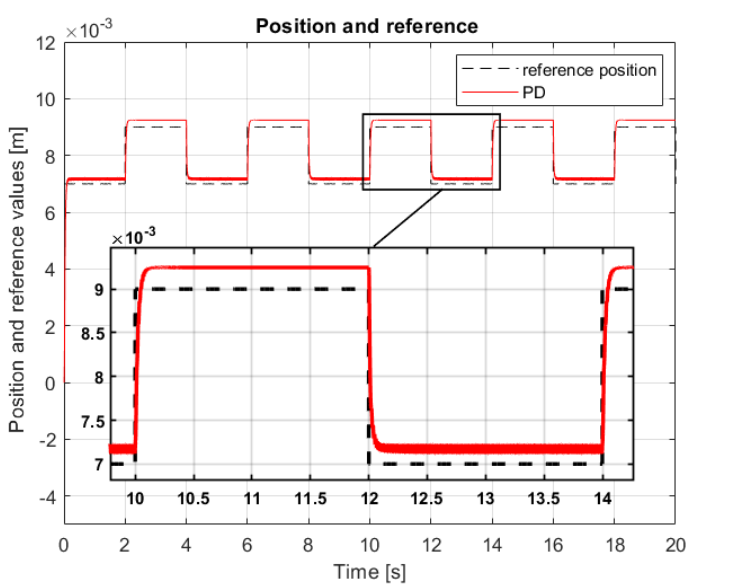
Figure 3. The system response—the PD controller case.